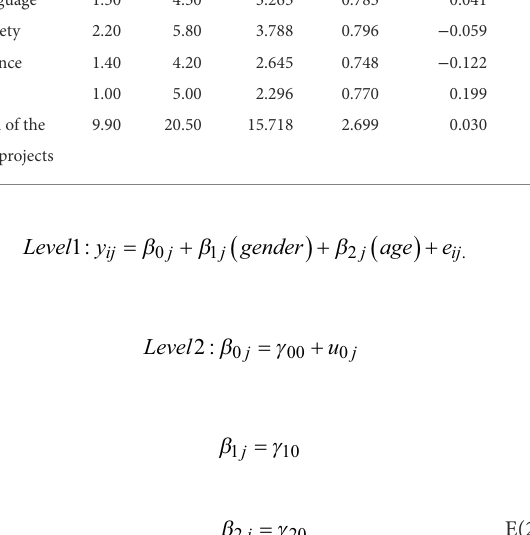
TABLE 4 The basic situation of the assessment of TFCP and the correlation with